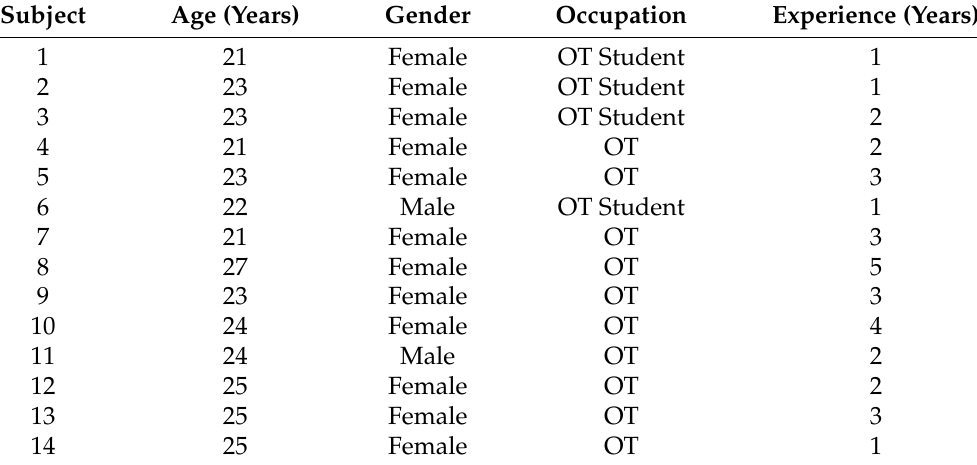
Table 1. Demographic information of the participants involved in the